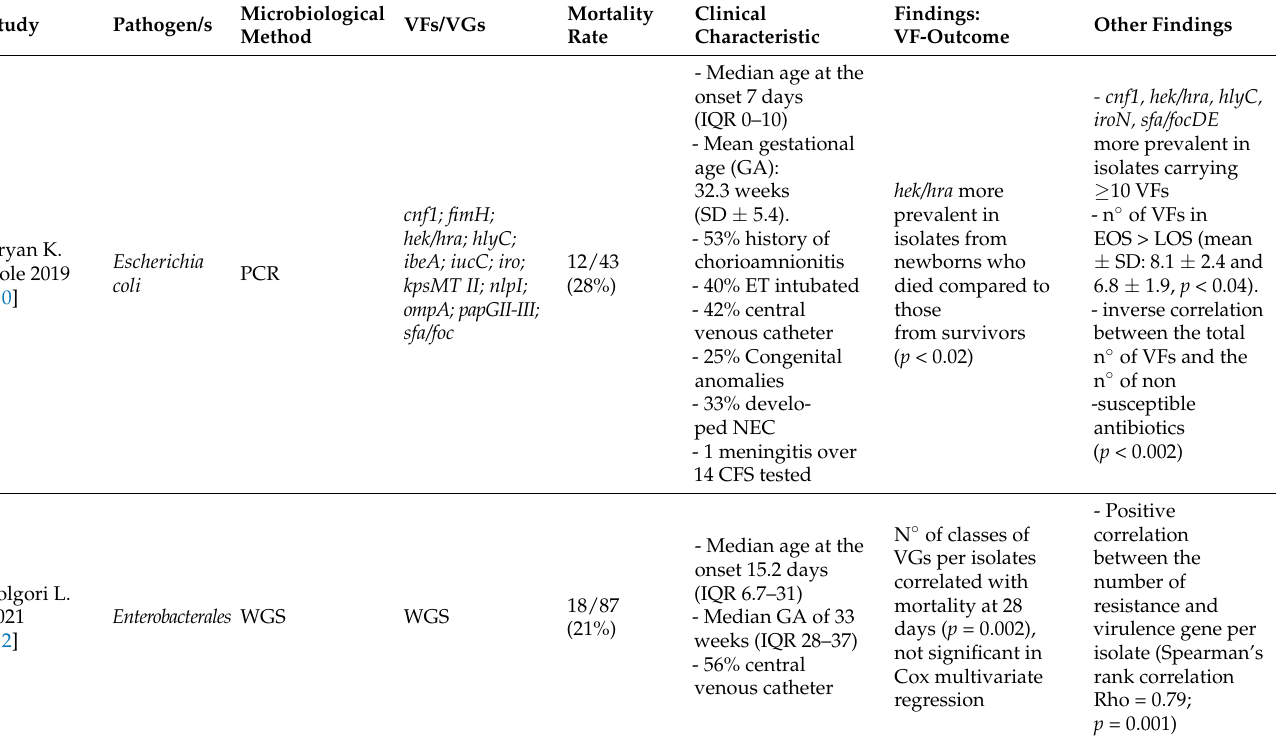
Table 1. Virulence factors (VFs)/virulence genes (VGs) associated with mortality among septi- caemic